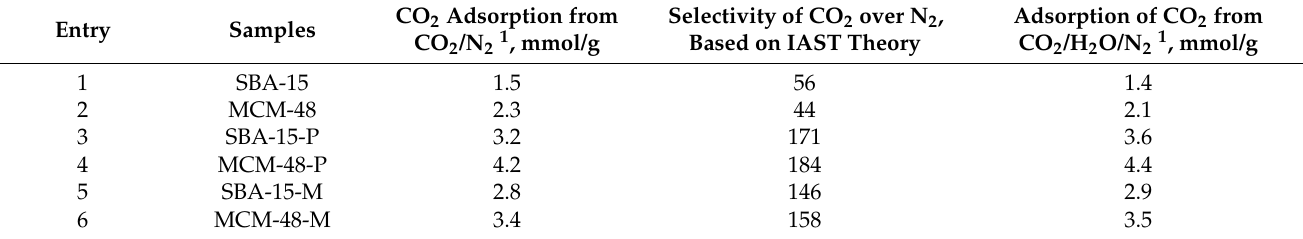
Table 2. CO 2 adsorption capacities of the prepared materials in dynamic